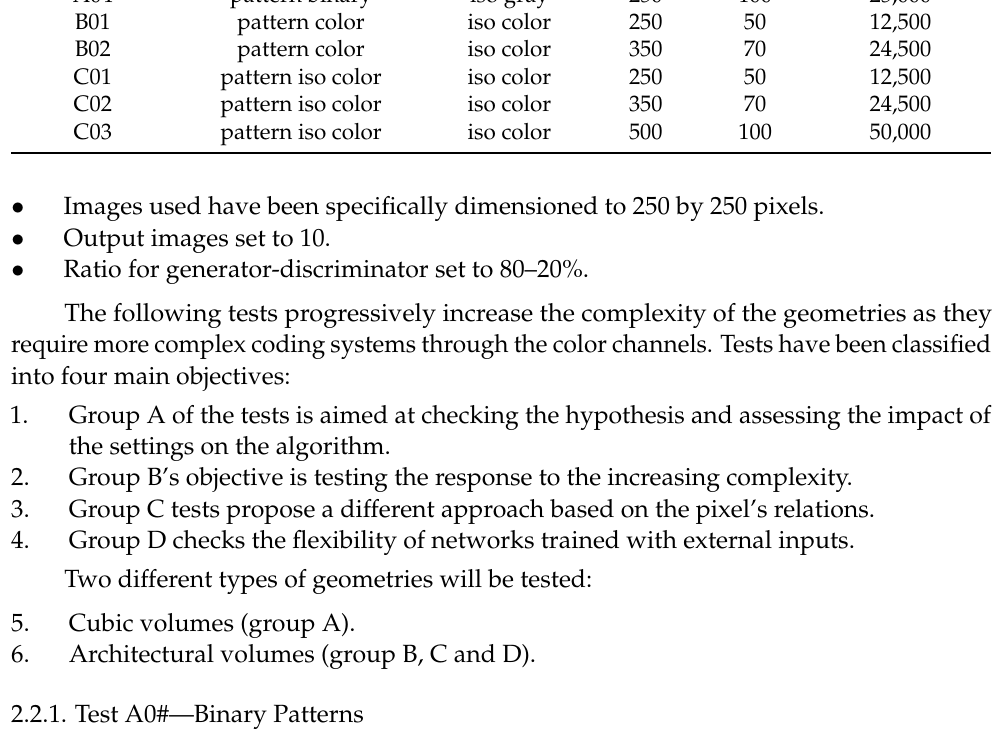
Table 5. Image comparison data from group A. A01